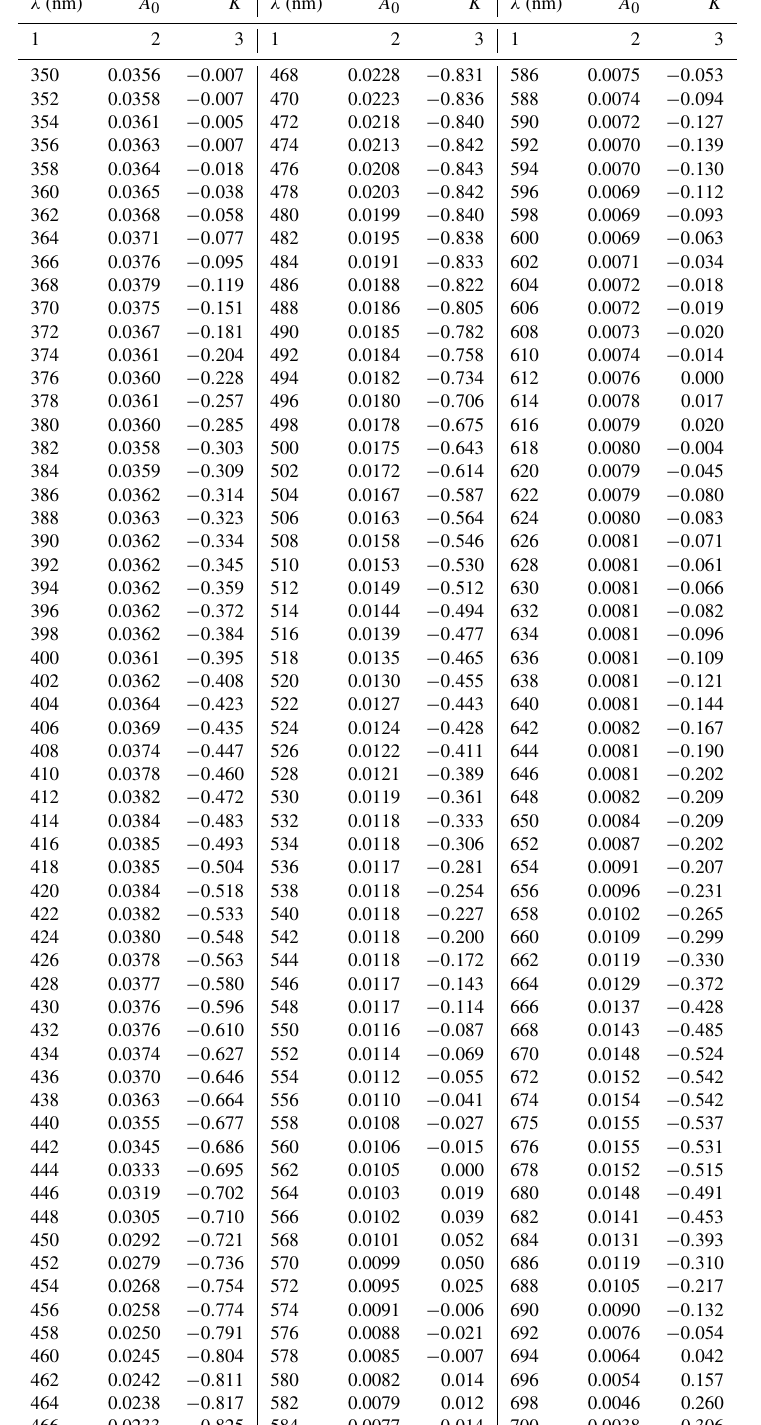
Table A3. Spectral coefficients A 0 and K of the two-component parameterization described by Eq. (4). The other coefficient E is the same as in the case of the one-component parameterization (see Table